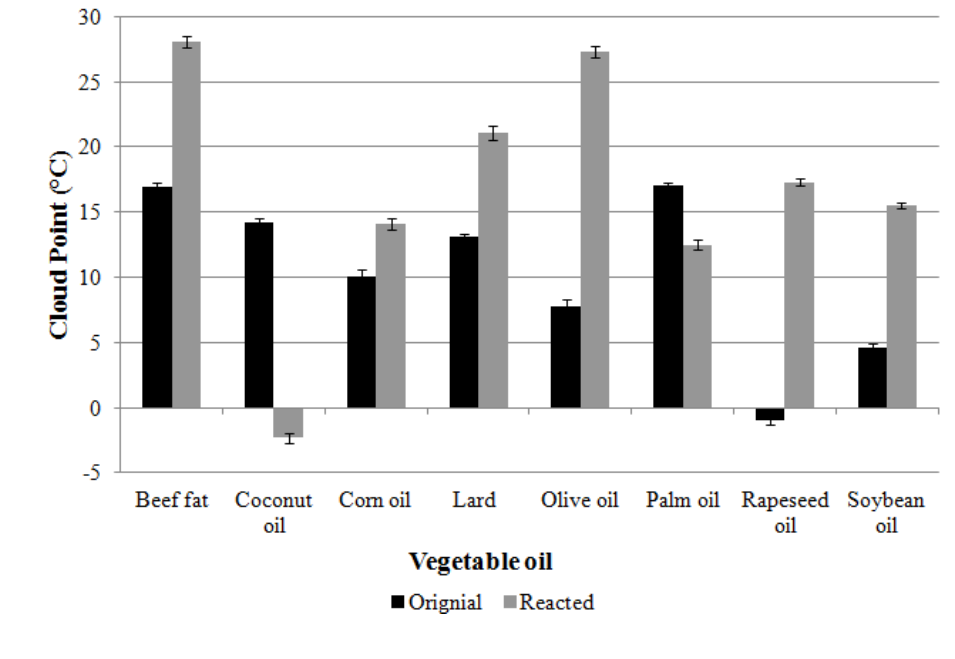
Figure 1. Cloud point changes of the various vegetable oil biodiesels before and after the isomerization and hydroisomerization